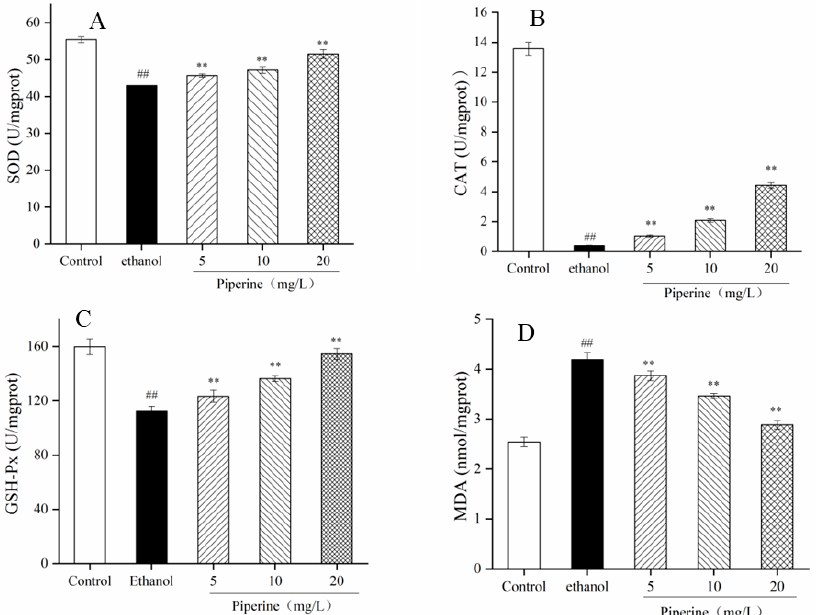
Figure 2. Effect of piperine pretreatment on oxidative factors in ethanol-treated GES-1 cells. ( A ) SOD; ( B ) CAT; ( C ) GSH-Px; ( D ) MDA. Ave ± SD, ## p < 0.01 vs. control group; ** p < 0.01 vs. ethanol group.